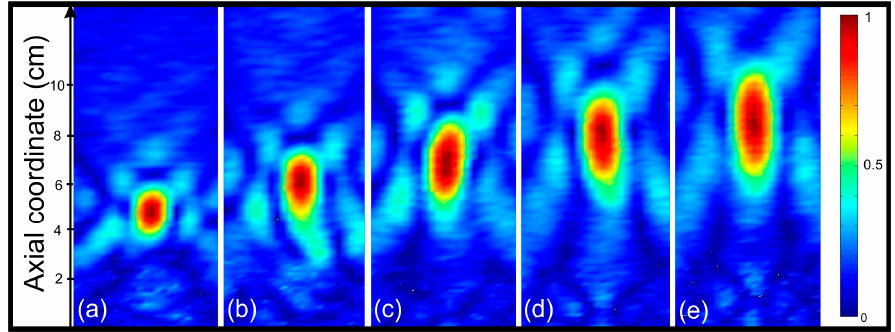
Figure 8. Measured normalized acoustic intensity maps for different operating frequencies: ( a ) 210 kHz; ( b ) 230 kHz; ( c ) 250 kHz; ( d ) 270 kHz; ( e ) 290 kHz.